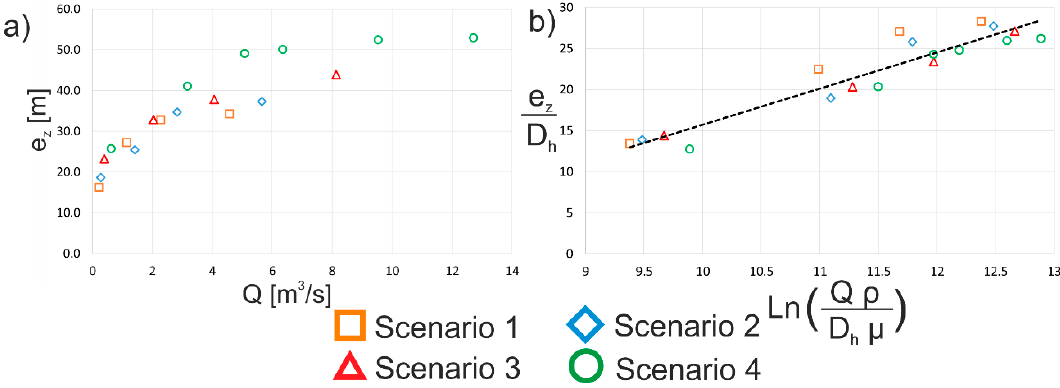
Figure 12. ( a ) Maximum effective distance (e z ) versus flow rate (Q); ( b ) dimensionless effective distance versus the logarithm of the dimensionless effective flow rate, for the different scenarios.